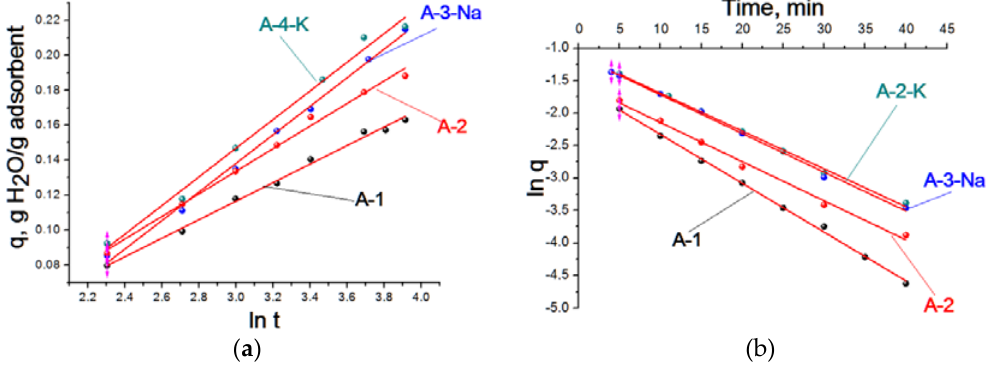
Figure 4. Approximations of the kinetic curves sorption of water vapor on the samples A ‐ 1, А‐ 2, A ‐ 3 ‐ Na, and A ‐ 2 ‐ K: ( a ) the value of adsorption (q): logarithm of time (ln t); ( b ) logarithm of value of adsorption (ln q) time (t).